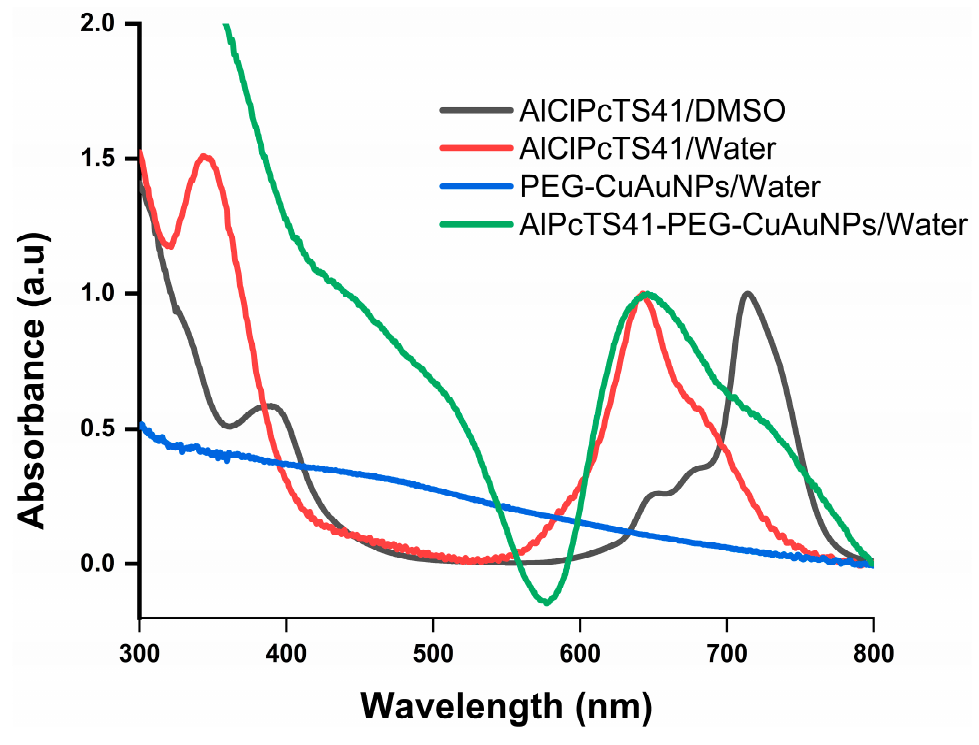
Figure 5. Normalized electronic absorption (ground state) spectra of AlClPcTS41 in water and DMSO with relation to the PEG-CuAuNPs and AlClPcTS41-PEG-CuAuNPs.